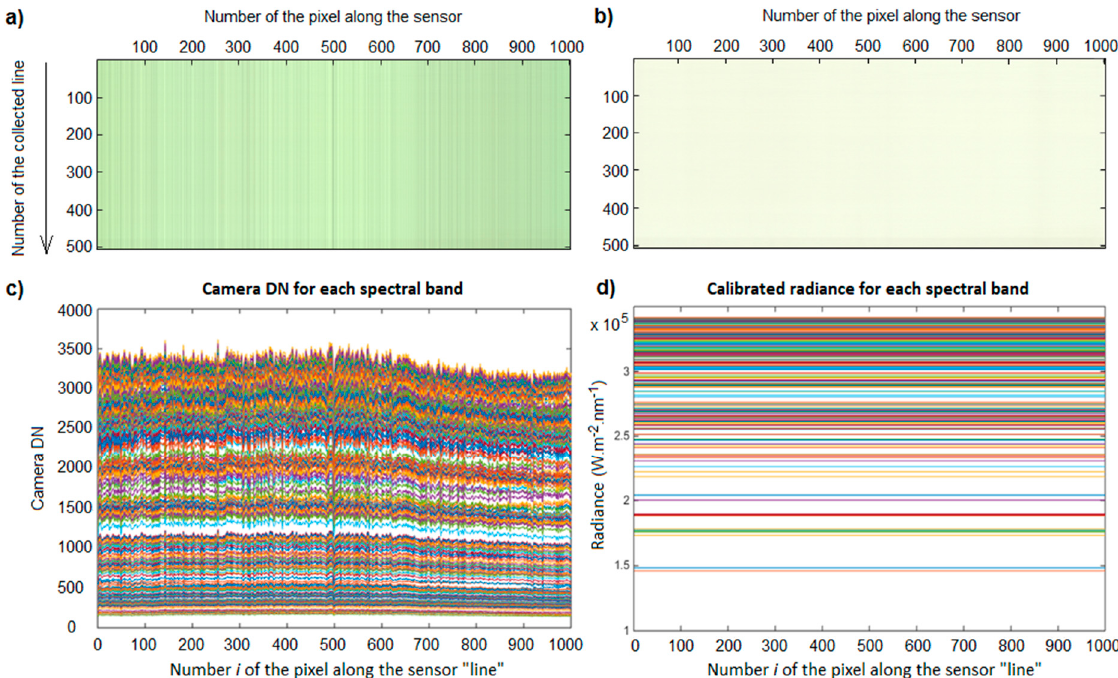
Figure 4. Hyperspectral lines collected above the white Spectralon by the hyperspectral camera before ( a , c ) and after ( b , d ) calibration. ( a , b ) represent, in natural colors, the hyperspectral lines collected by the camera; ( c , d ) represent the values of digital number (DN) ( c ) and radiance ( d ) along the sensor line for each spectral band (in colors).